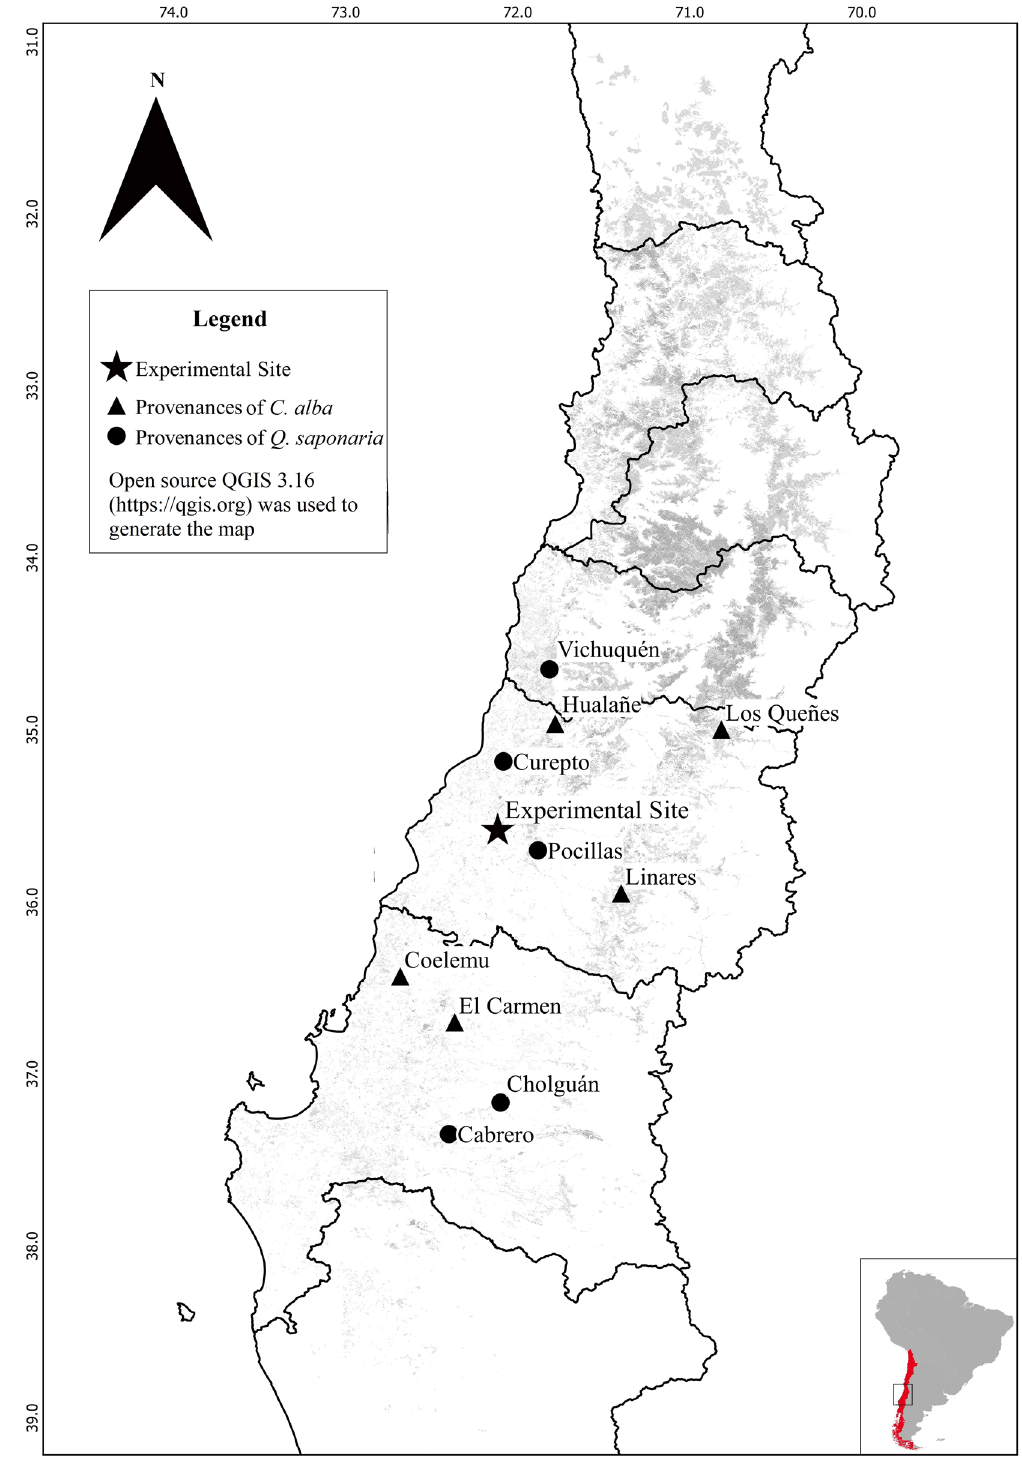
Figure 1. Location of the provenances origin and the experimental site. The approximate range of distribution of both species in central Chile is indicated by a square in the inset